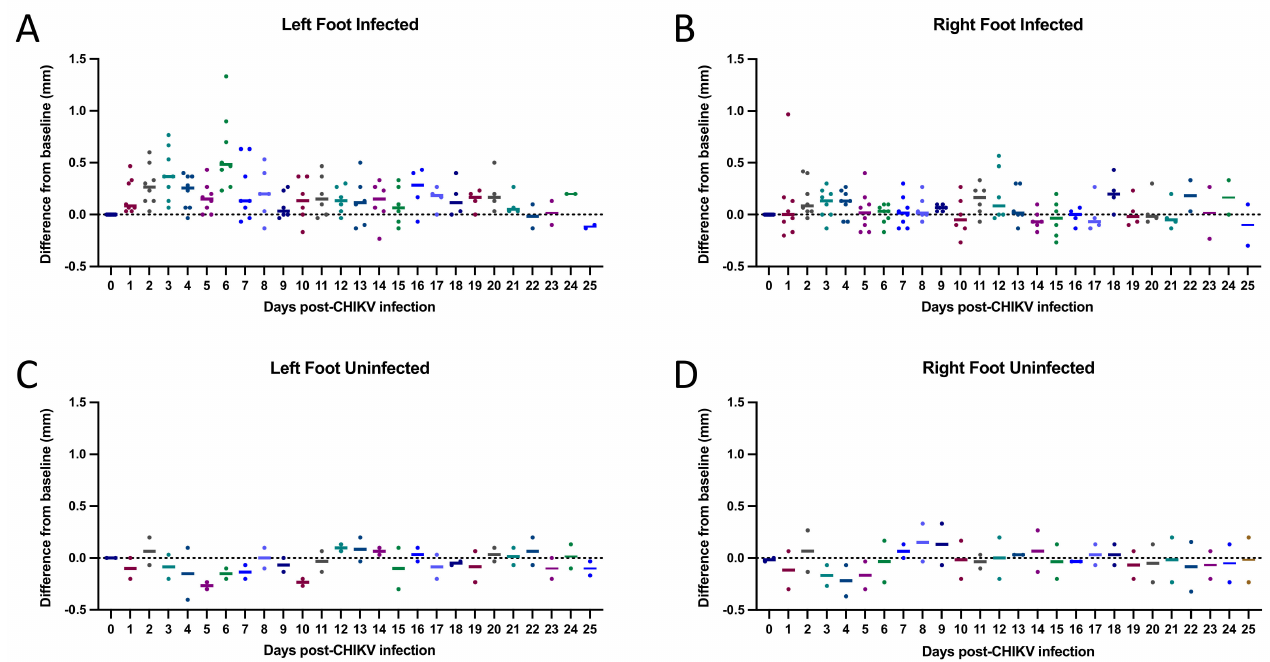
Figure 3. Tarsal joint measurements per mouse by days post infection (DPI). Scatter plots showing the differences from baseline tarsal joint measurements for each day post-CHIKV infection. Mice were injected with approximately 25 µ L intradermal of CHIKV inoculum ( A , B ) or PBS ( C , D ) in the left footpad on Day 0. Tarsal joint measurements were baselined by subtracting Day 0 pre-infection measurements for each mouse from the post-infection measurements. Horizontal solid lines represent the mean difference from baseline for each